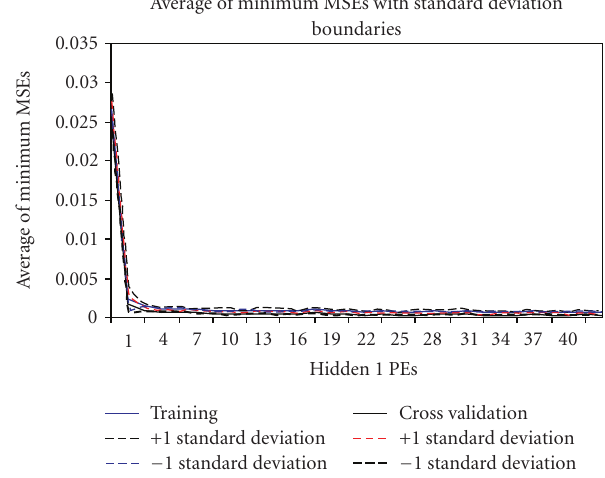
Figure 8: Modeling capability of FTLRNN on testing dataset for EMG signal.